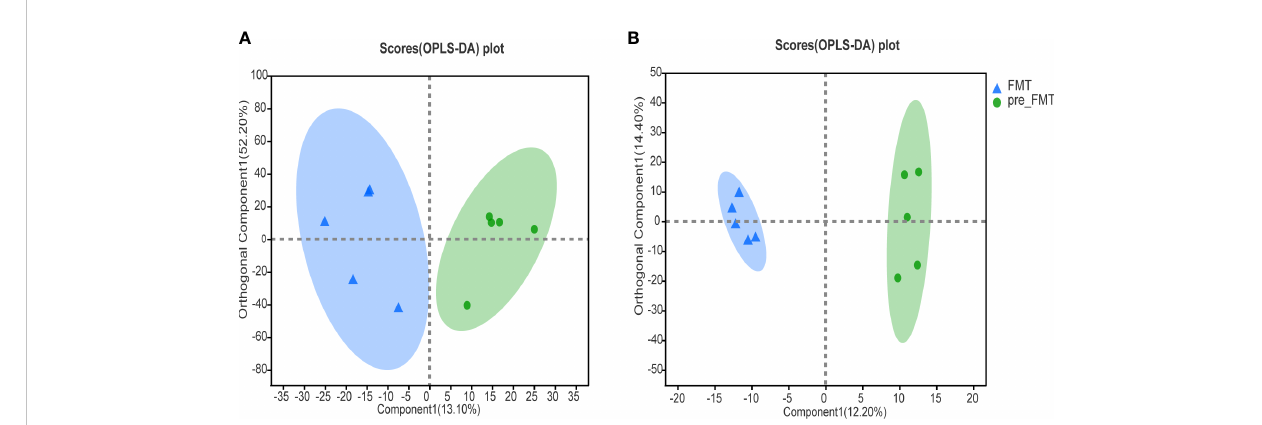
FIGURE 3 Heatmap of serum metabolomics correlation before and after FMT. (A) OPLS-DA analysis of cation pro fi les. (B) OPLS-DA analysis of anion